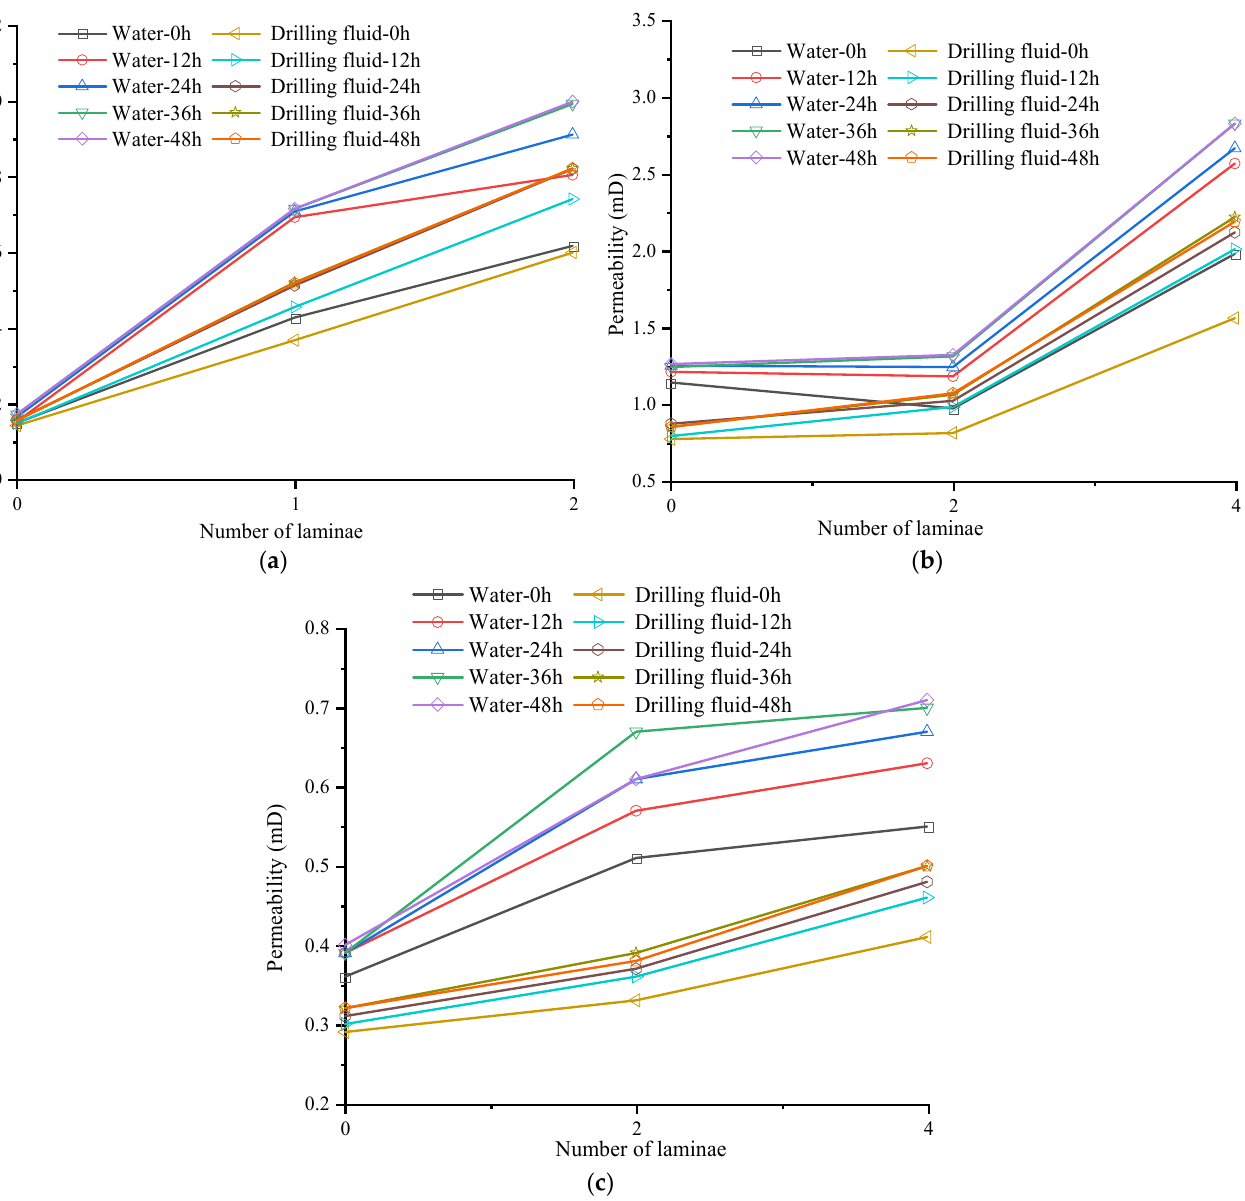
Figure 6. Permeability under the different lamina densities: ( a ) The relationship between density and permeability of rock samples under 0° sampling; ( b ) the relationship between density and permeability of rock samples under 45° sampling; ( c ) the relationship between density and permeability of rock samples under 90° sampling.